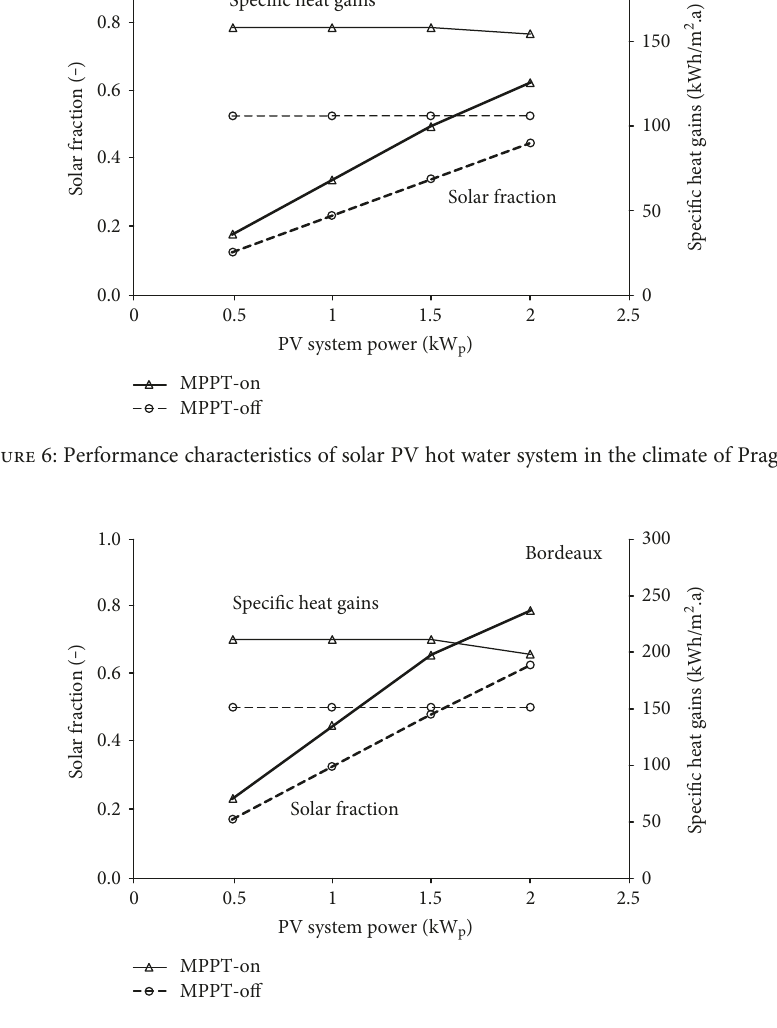
Figure 7: Performance characteristics of solar PV hot water systems in the climate of Bordeaux.